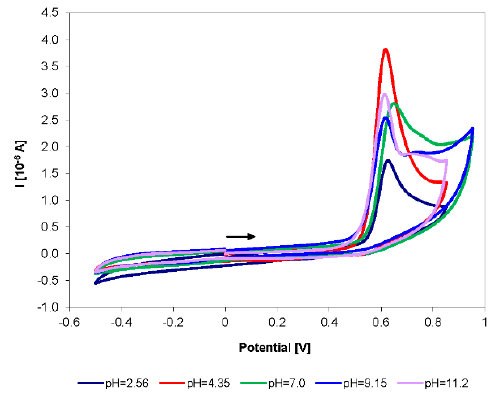
Figure 2. Cyclic voltammograms of 2.7 × 10 − 5 mol · L − 1 posaconazole in Britton-Robinson (B-R) bu ff er in the pH 1.8–11.2 range; v = 100 mV · s − 1